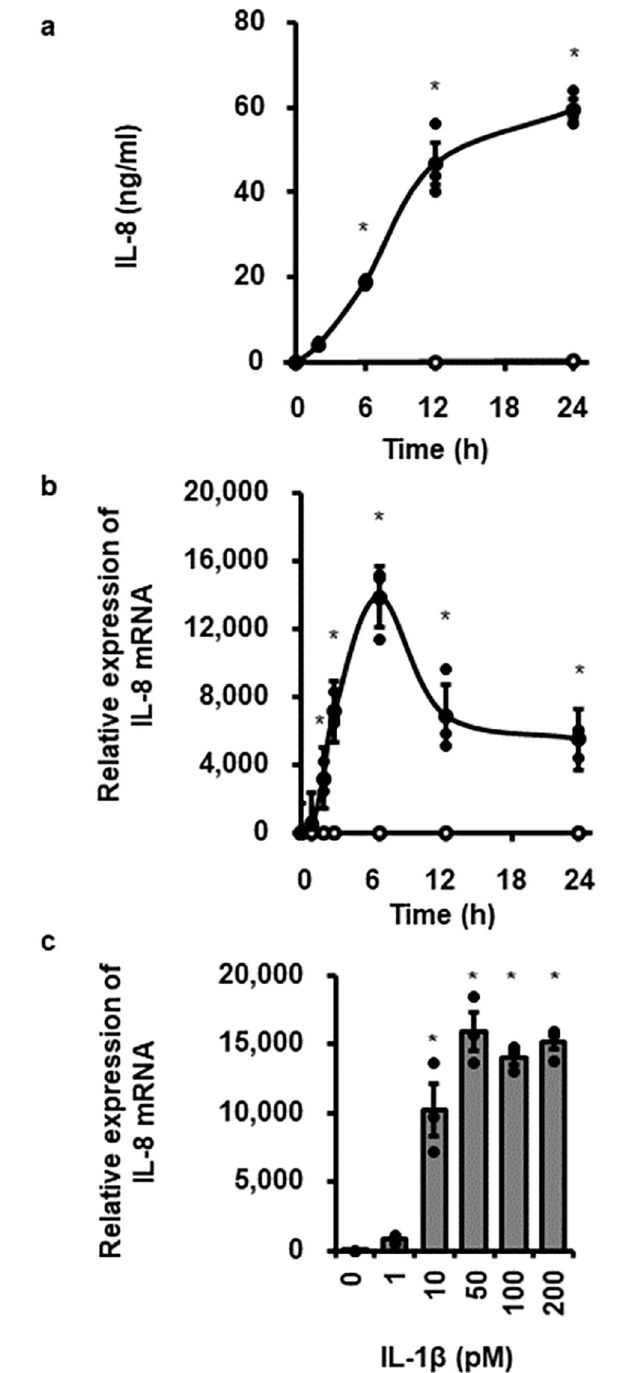
Fig 1. IL-1 β -induced IL-8 release and IL-8 mRNA expression in canine dermal fibroblasts. Time-dependent increase in IL-8 protein release (a) and IL-8 mRNA expression levels (b) in cells treated with (closed circle) or without (open circle) canine recombinant IL-1 β (100 pM). (c) Dose-dependent increase in IL-8 mRNA expression levels in cells treated with the indicated concentrations of IL-1 β for 6 h. TBP was used as an internal standard and the expression levels of IL-8 mRNA in IL-1 β -stimulated cells were compared with the expression at 0 h. Results have been represented as mean ± standard error (SE) from biological triplicates. � P < 0.05.